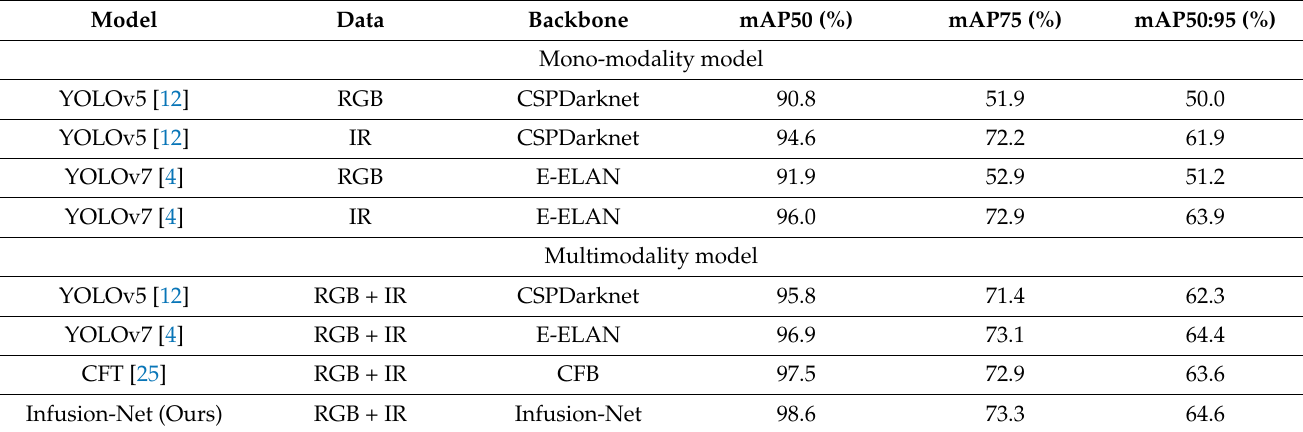
Table 2. Comparison of the Infusion-Net and other models on the LLVIP dataset [7].